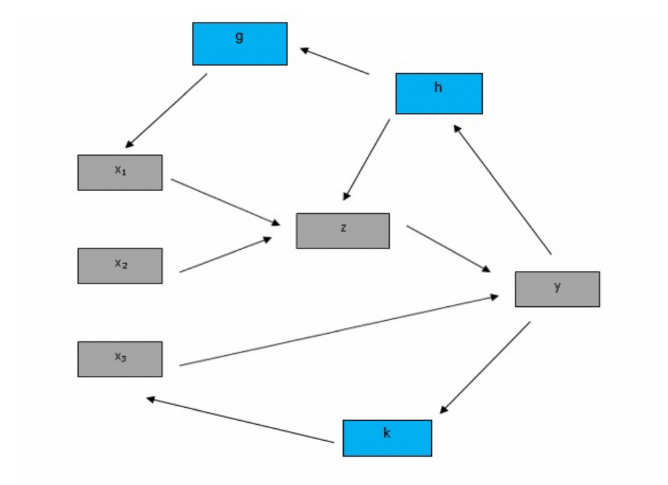
Figure 2: Feedback